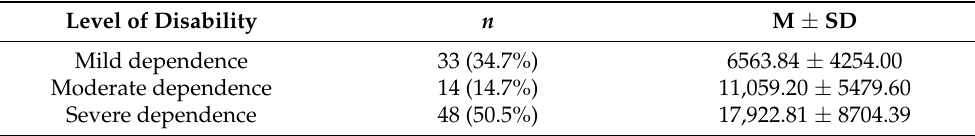
Table 4. Cost of informal care according to the level of disability. ( n =